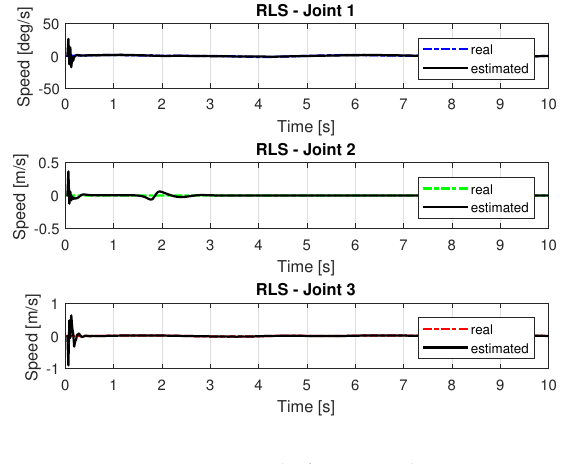
Figure 13. Speed of joints with RLS.